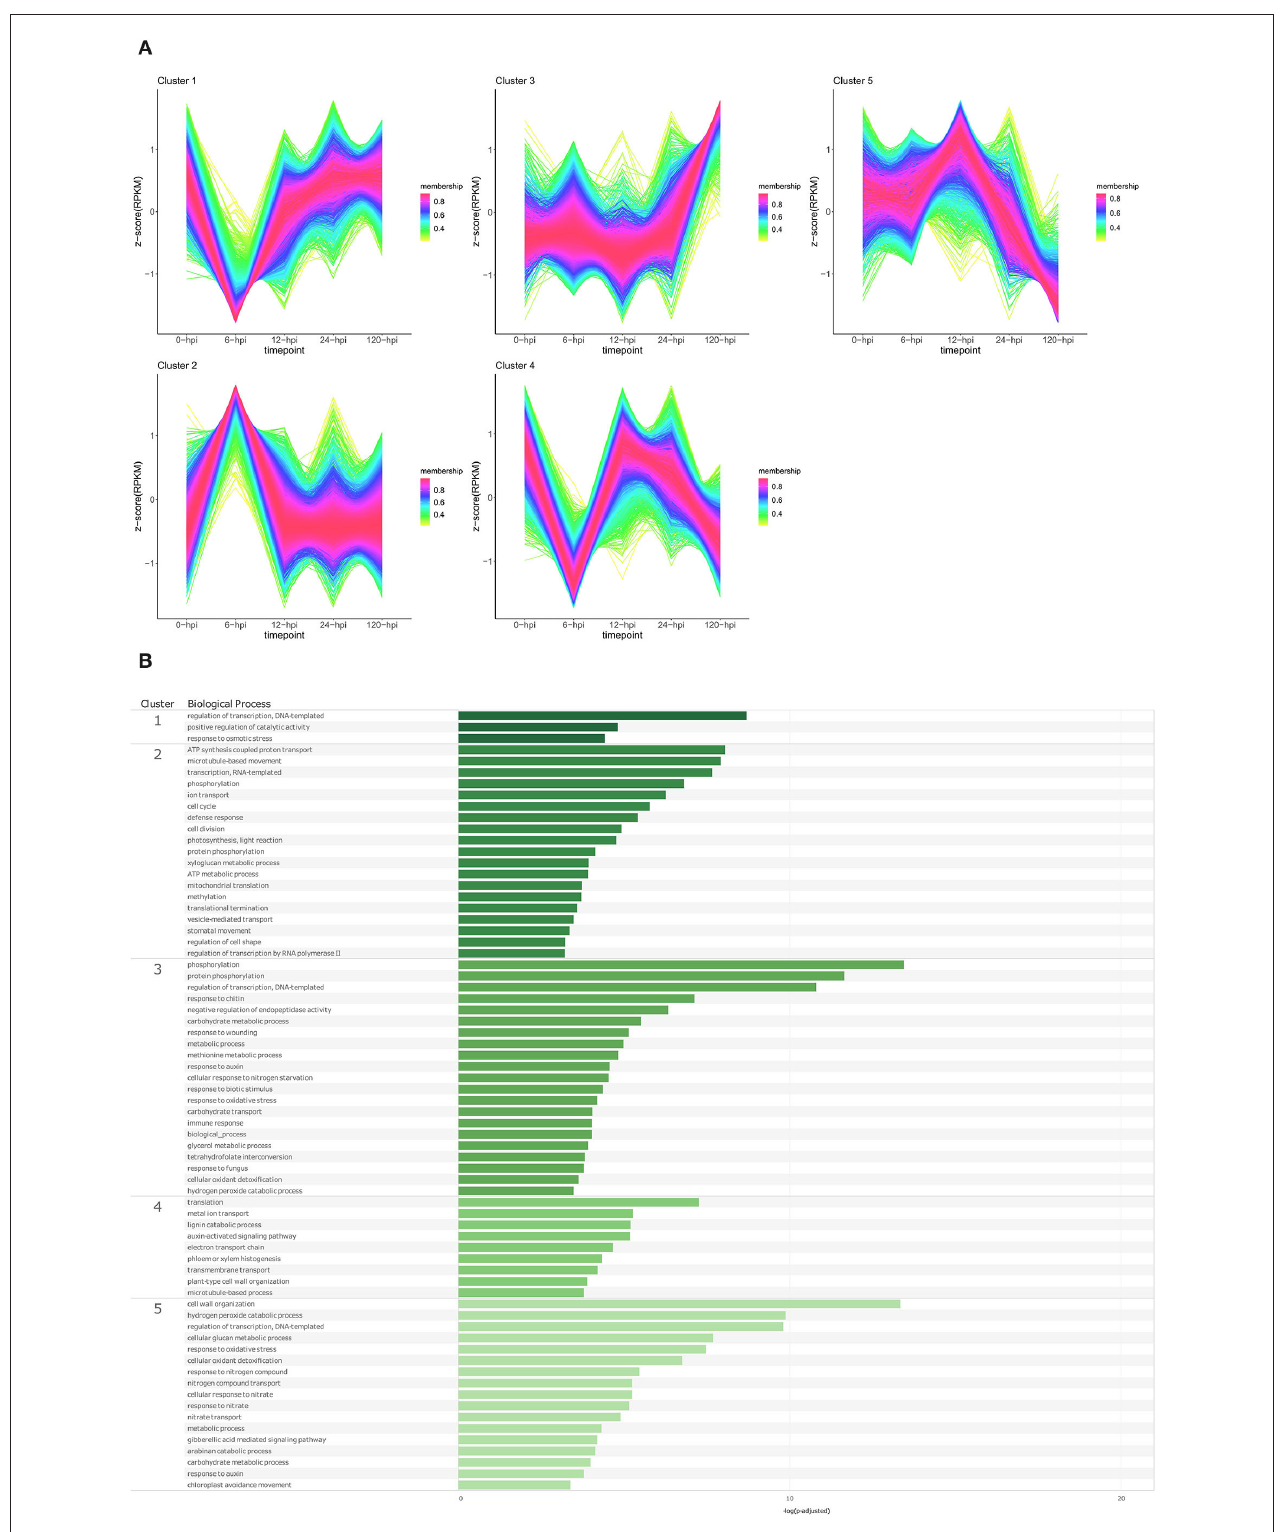
FIGURE 5 | Temporal clustering and Gene Ontology enrichment of Persea americana differentially expressed genes (DEGs) in R0.12 following inoculation with Phytophthora cinnamomi. (A) Sample libraries from the susceptible P. americana rootstock R0.12 following inoculation with P. cinnamomi or mock inoculation (dH 2